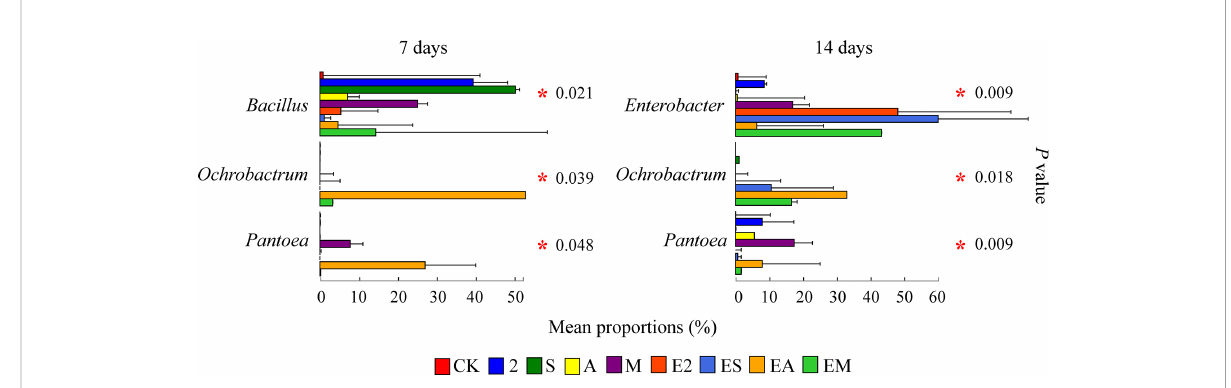
FIGURE 8 Proportions of bacterial genera with high relative abundances in chemoattractant and chemoattractant-plus-chemotactic strain treatment groups at 7 and 14 days. Asterisks in red indicate a signi fi cant difference among treatments ( P <